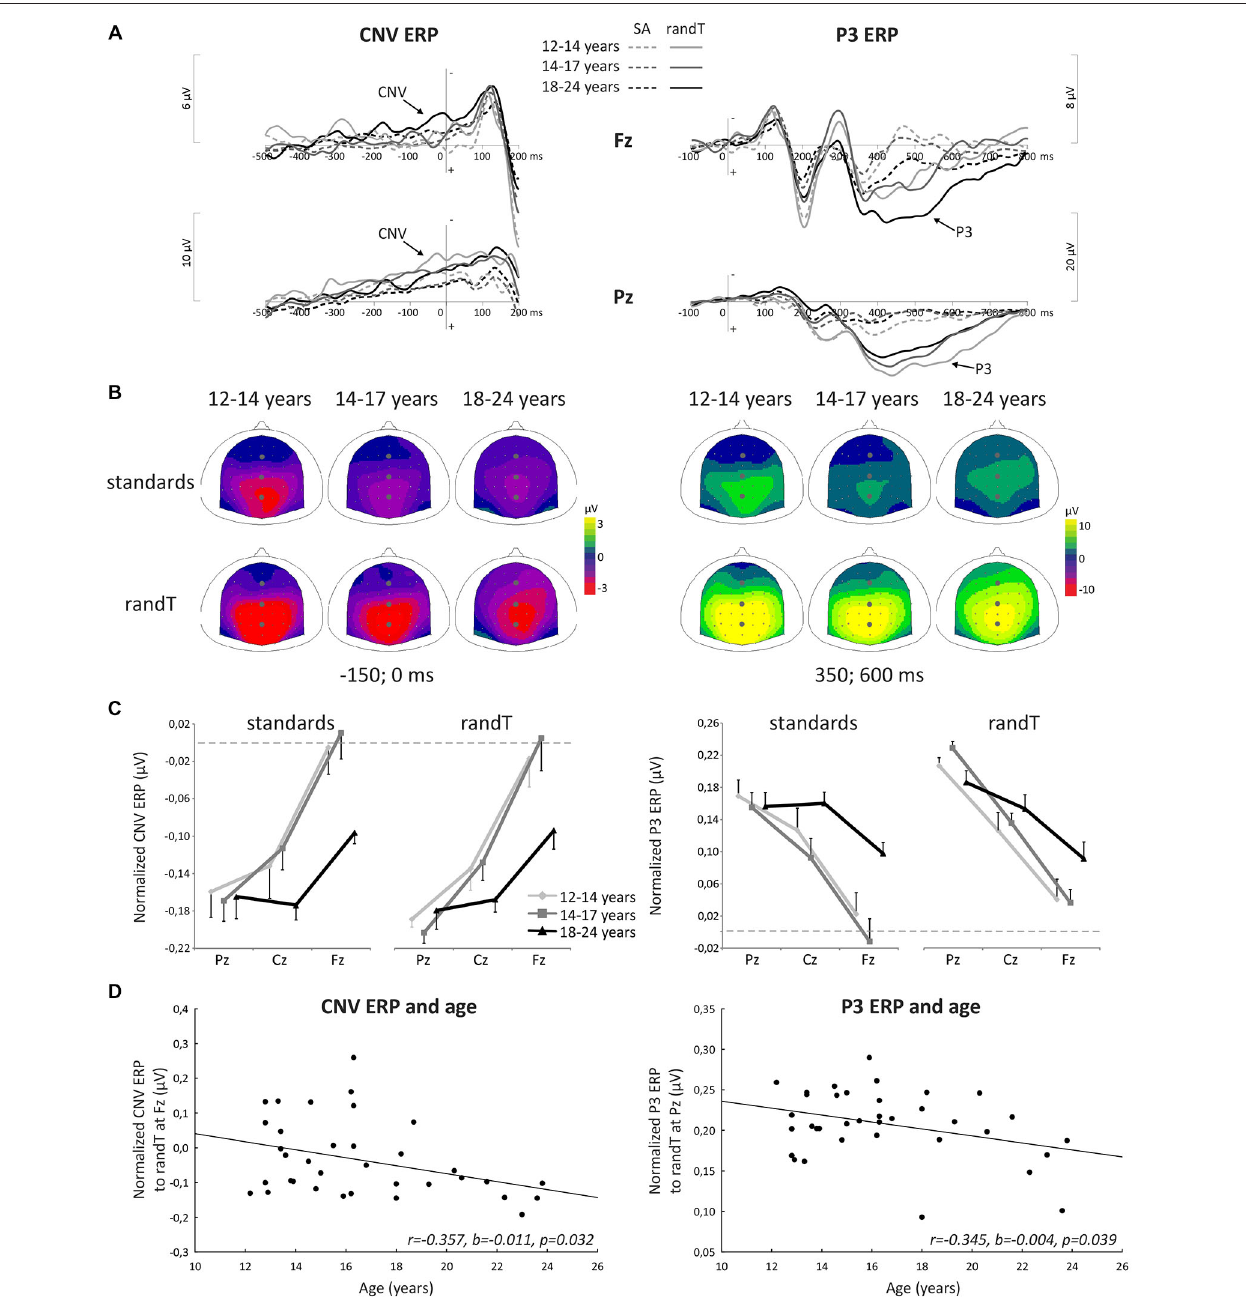
FIGURE 3 | Attentional processes. (A) Grand-average ERP waveforms band-pass filtered between 0.5 and 30 Hz, at the Fz and Pz electrodes. (B) Scalp topographies (top views) of the mean ERP (CNV and P3) values in the − 150–0 ms and 350–600 time-windows. The gray dots indicate the position of Fz, Cz and Pz electrodes. (C) Normalized CNV and P3 amplitudes (microvolts) at Fz, Cz and Pz electrodes. Data for standards (left) and randTs (right) are shown for the three age groups. Error bars: standard errors of mean. (D) Normalized CNV amplitude (microvolts) preceding randTs at Fz plotted against age in years. Normalized P3 amplitude (microvolts) to randTs at Pz plotted against age in years. The solid lines represent the linear